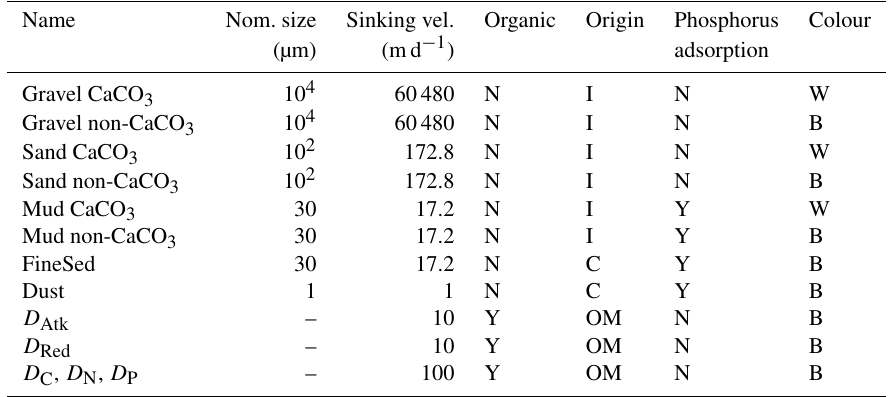
Table 33. Characteristics of the particulate classes. Y – yes, N – no, I – initial condition, C – catchment, OM – remineralisation from organic matter, B – brown, W – white (Condie et al., 2009; Margvelashvili, 2009). Nom. size Sinking